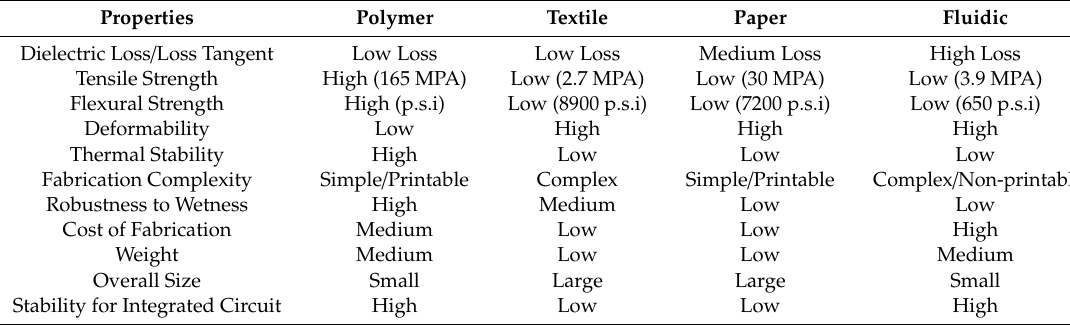
Table 4. Comparison of di ff erent flexible materials